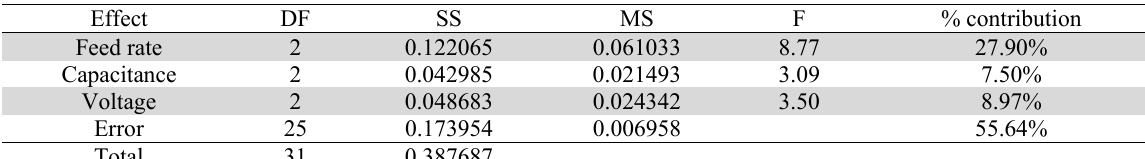
ANOVA results for MRR